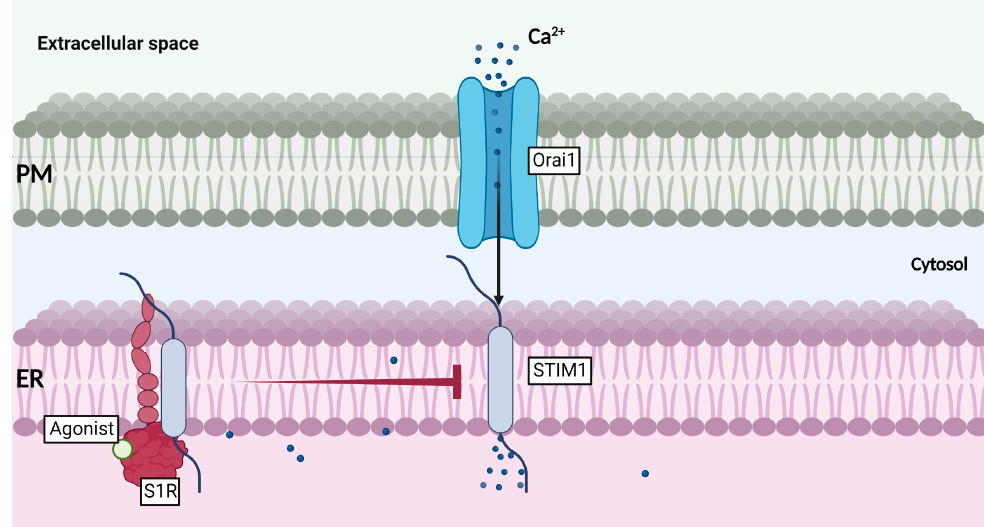
Figure 5. Function of S1R at the ER-PM junctions in ER-calcium